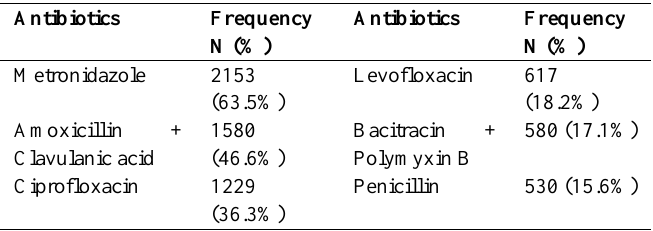
Table 5: Antibiotics used as self medication